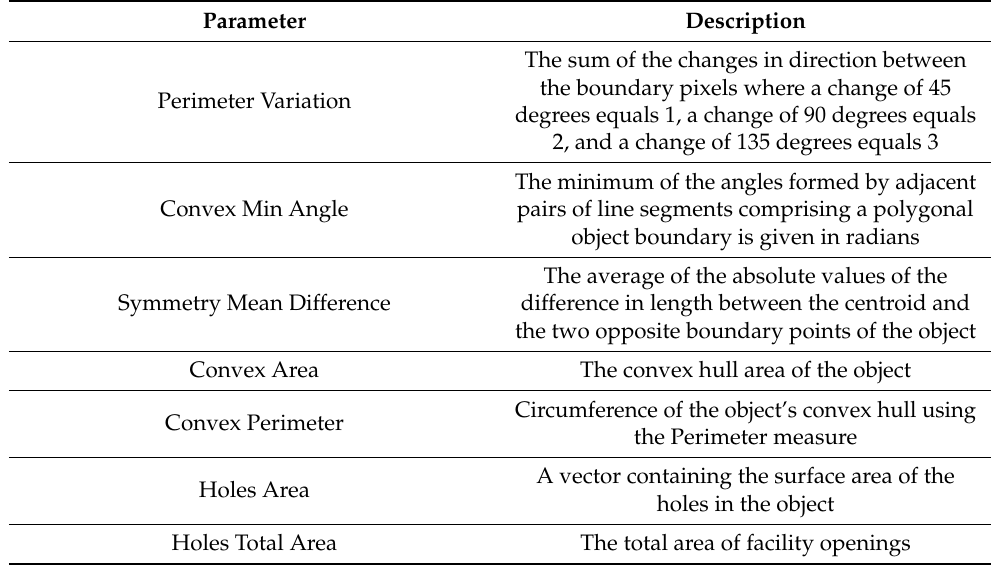
Table 5. Cont. Parameter Description The sum of the changes in direction between Perimeter Variation